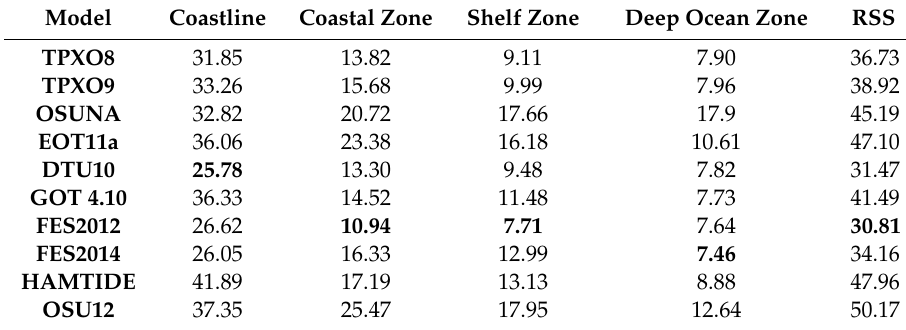
Table 6. Mean RMS values (in cm) of the SLA, calculated by detiding SLA using di ff erent ocean tidal models, based on one year of hourly tide gauge observations in coastline and three years of Sentinel-3A data (40 cycles) over other zones, in the GBR. The smallest mean RMS values are indicated by bold numbers.